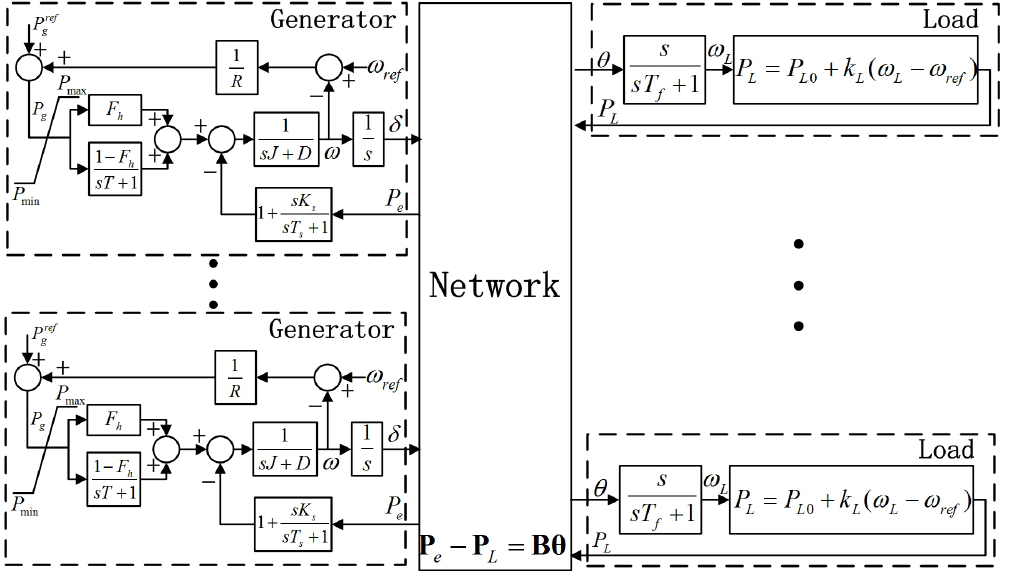
Figure 3. Diagram of DFR